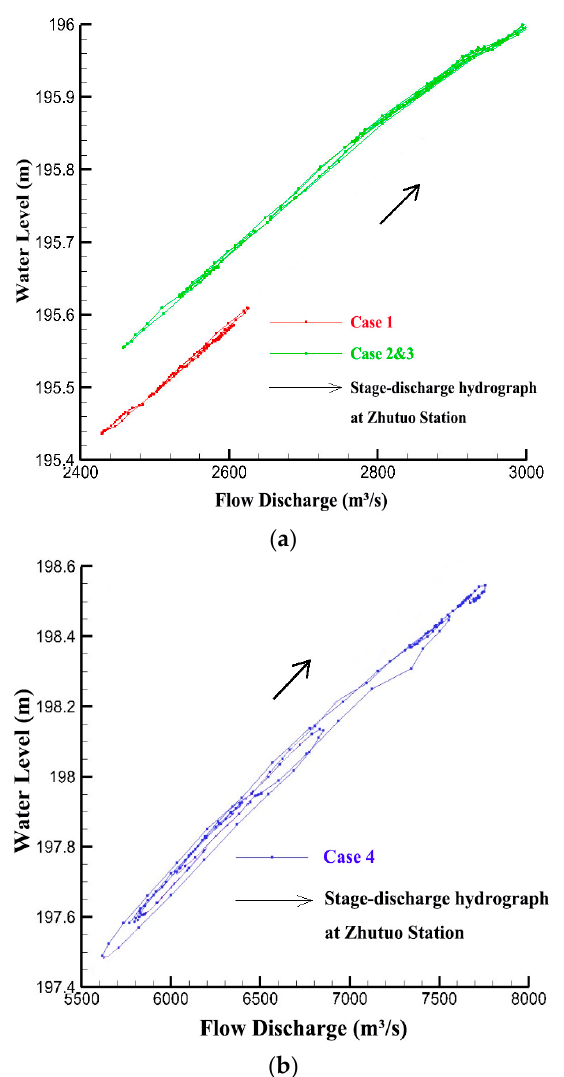
Figure 8. Stage–discharge hydrograph at Yibin Station: ( a ) Case 1–3; and ( b ) Case 4.